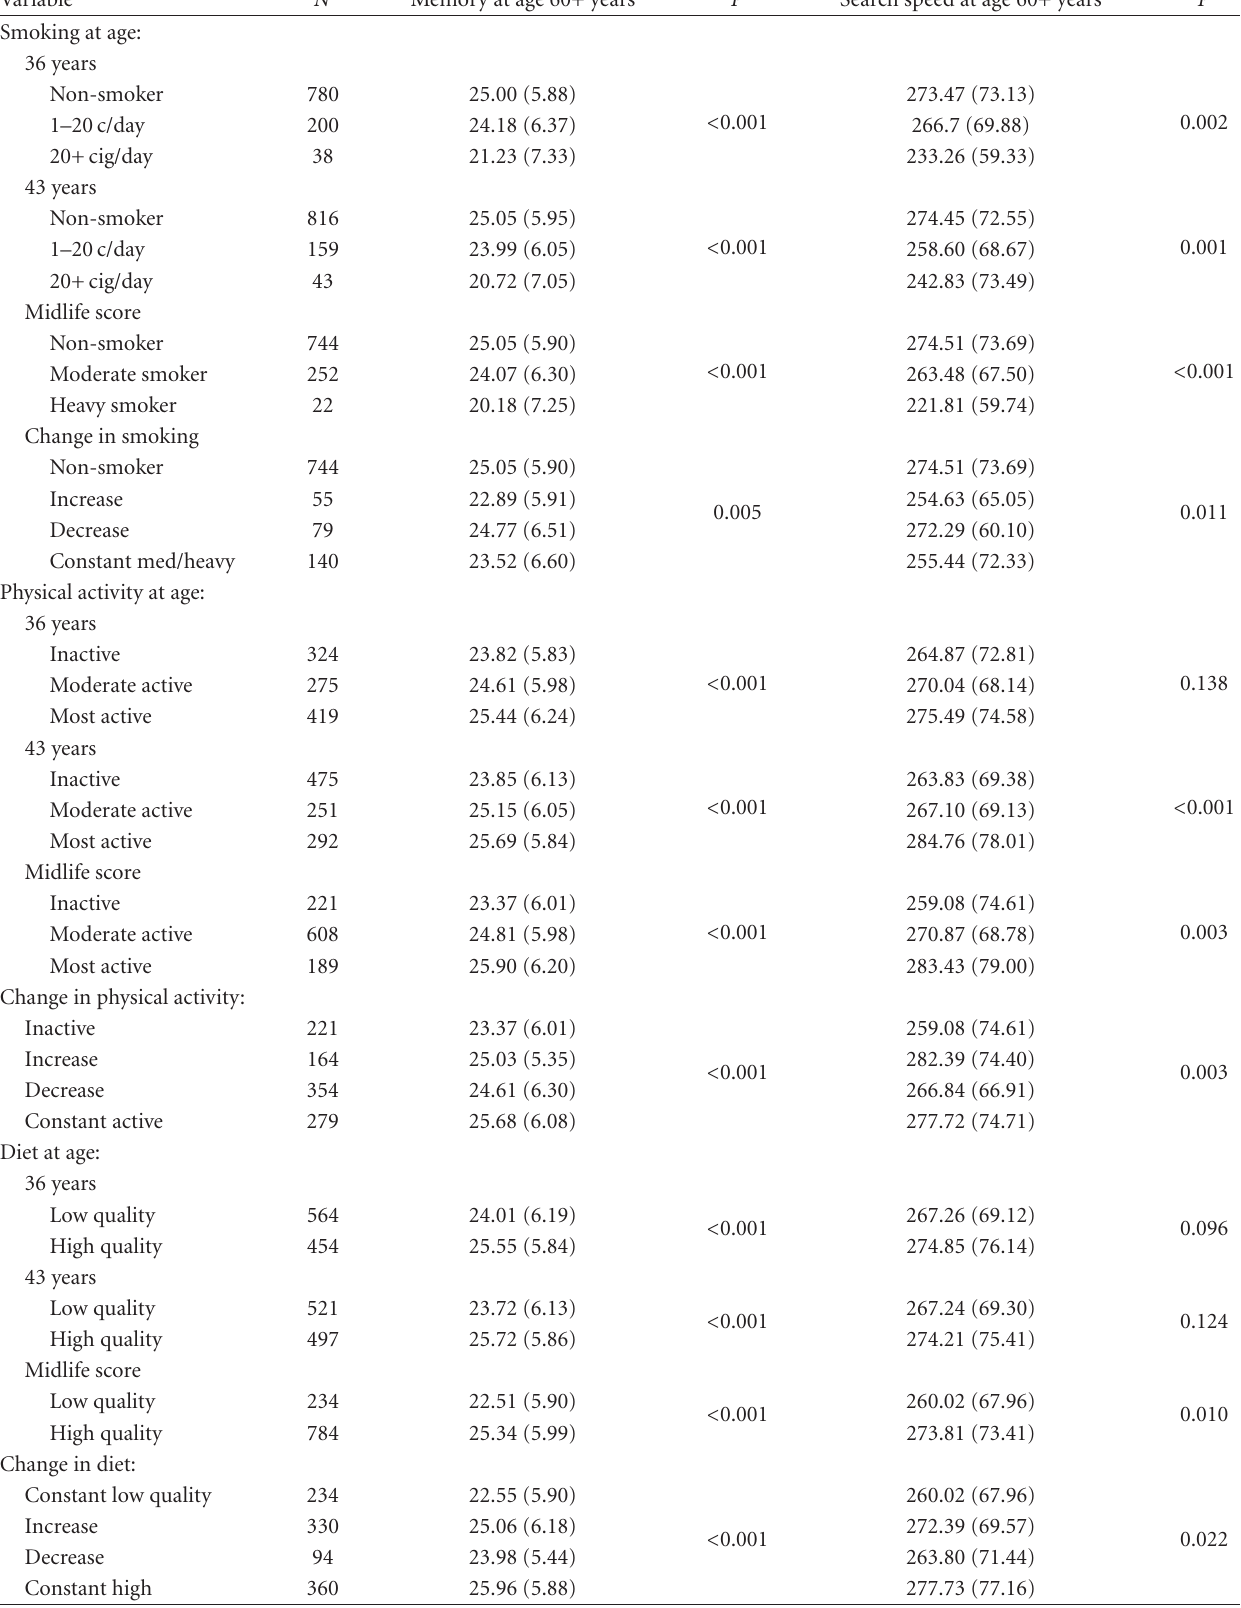
Table 1: Characteristics and mean scores for memory and search speed at age 60+ years, by lifestyle behaviour profiles and dichotomous